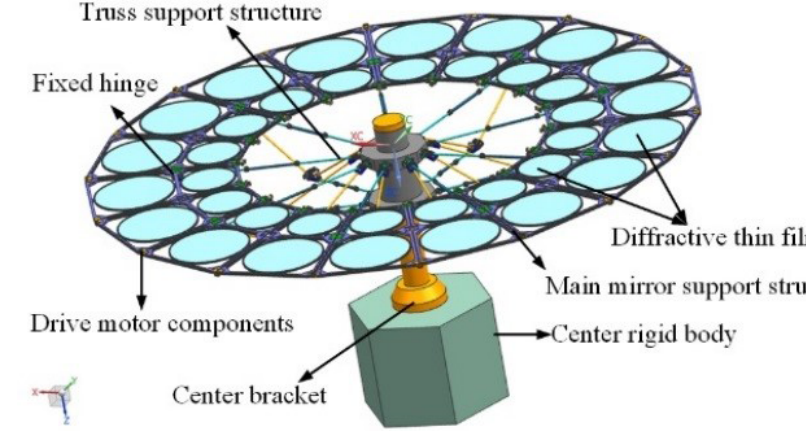
Figure 1. Overall structure of the thin-film diffraction imaging system.